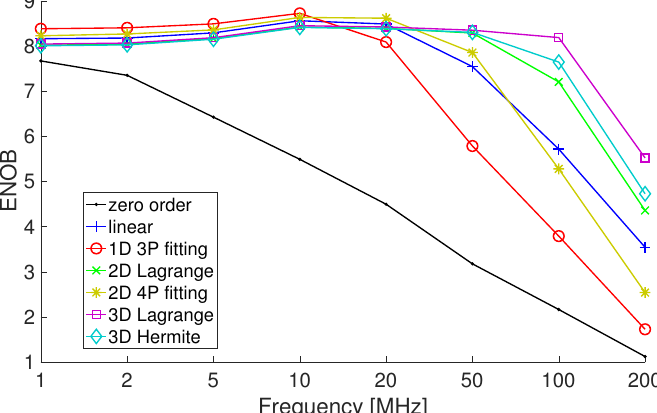
Figure 3. Effective number of bits (ENOB) offered by the resampling approaches based on the use of approximating